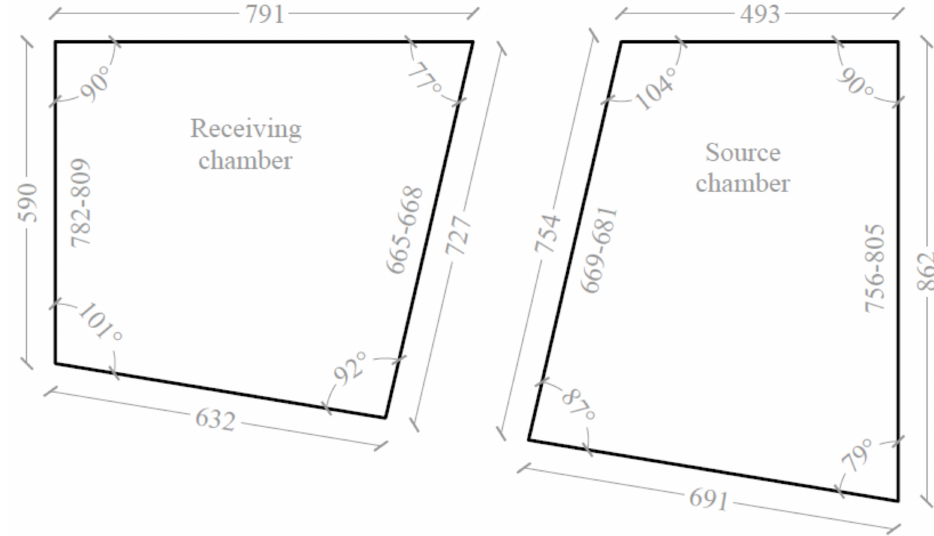
Figure 2. Detailed dimensions (in mm) of the coupled reverberation rooms at the 1:8 scale; the intervals define the walls heights that vary along the